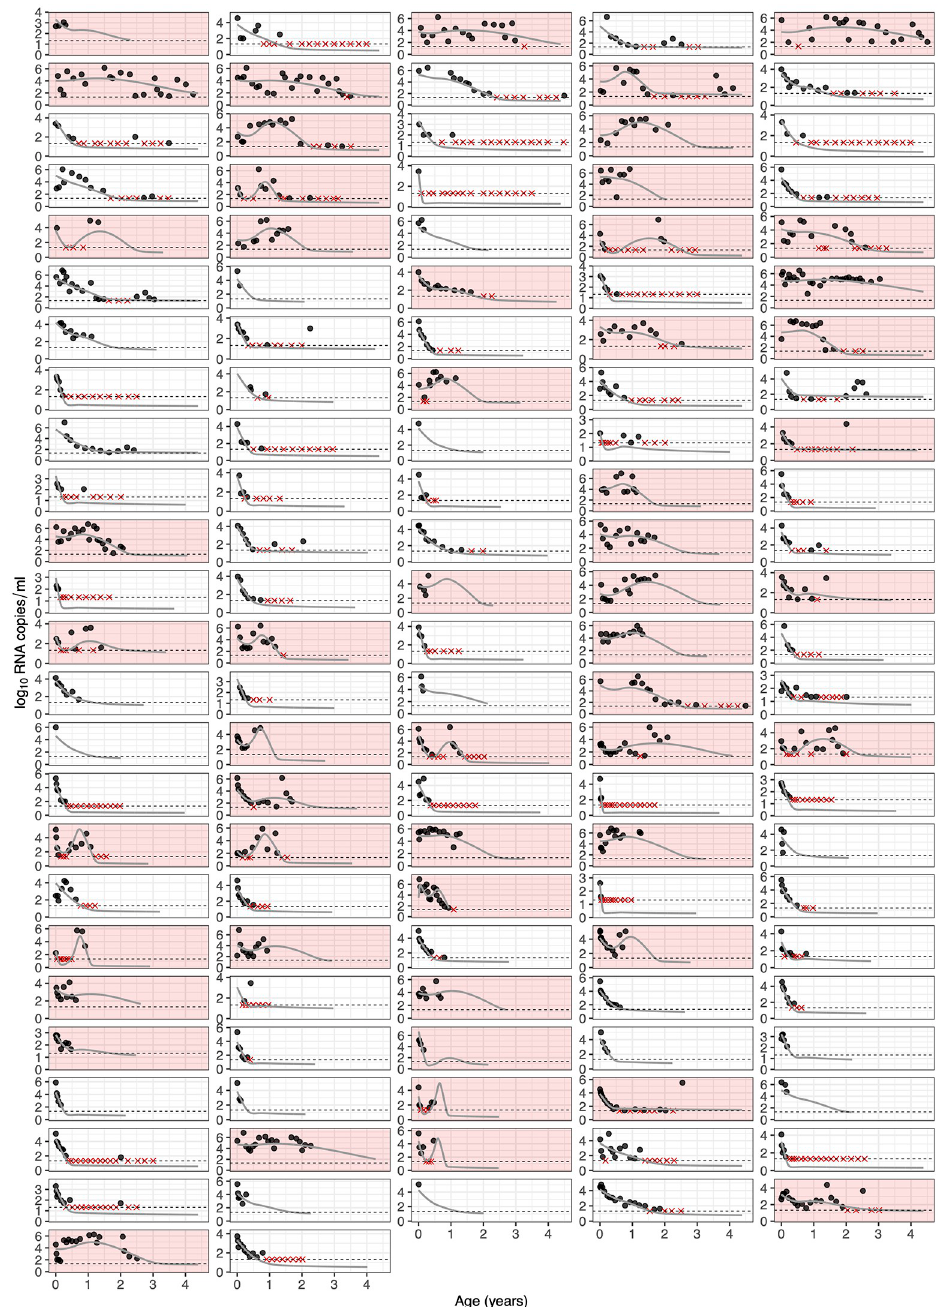
Fig 2. Model fits for viral RNA observations. Each panel represents a different infant; points represent the data; and solid lines are the model fits. The dashed horizontal line is the detection threshold of the RNA assay, and red crosses are censored observations below this threshold. Panels shaded in red are infants who experienced viral resurgence (i.e. at least one period of increasing VL).